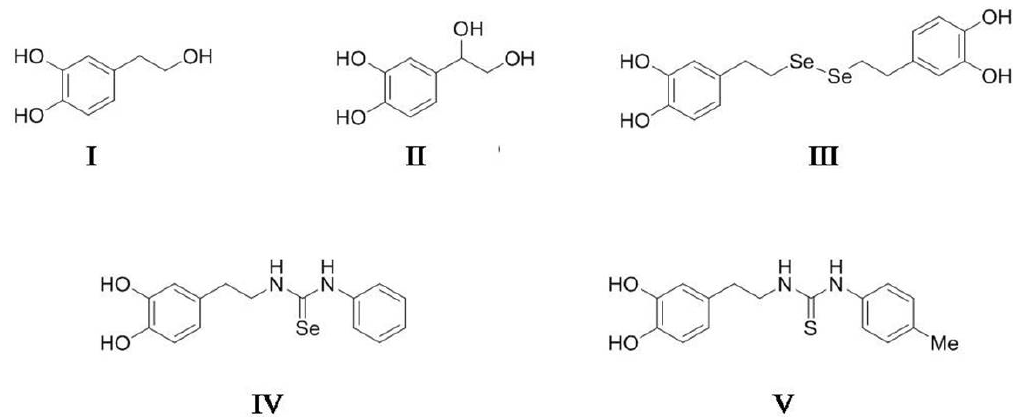
Figure 1. Chemical structures of hydroxytyrosol (HT) ( I ), 3,4-dihydroxyphenylglycol (DHPG) ( II ), dihydroxytyrosyl diselenide (diselenide of bis-HT) ( III ), N -hydroxytyrosyl selenourea (selenourea) ( IV ), and N -hydroxytyrosyl thiourea (thiourea) ( V ).